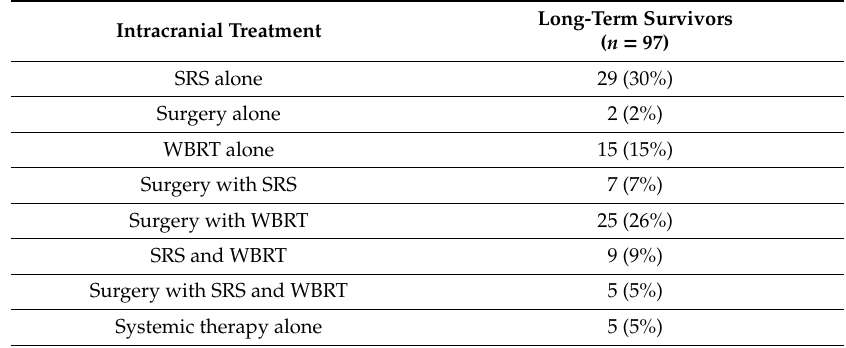
Table 3. Details of intracranial treatment during the initial diagnosis of brain metastases for the long-term